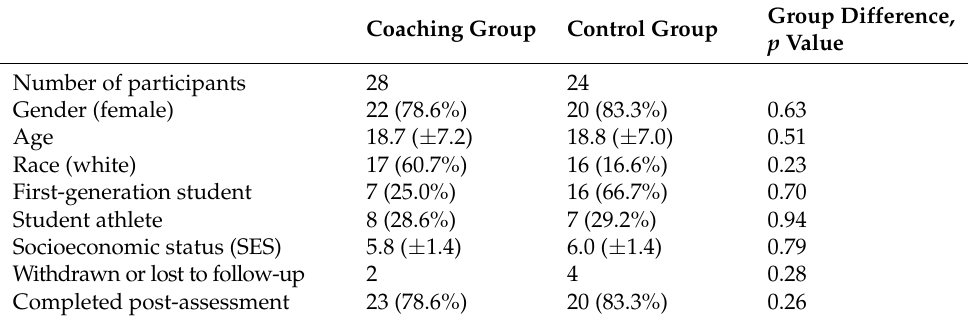
Table 1. Participants’ Demographic Characteristics and Completion Rate.